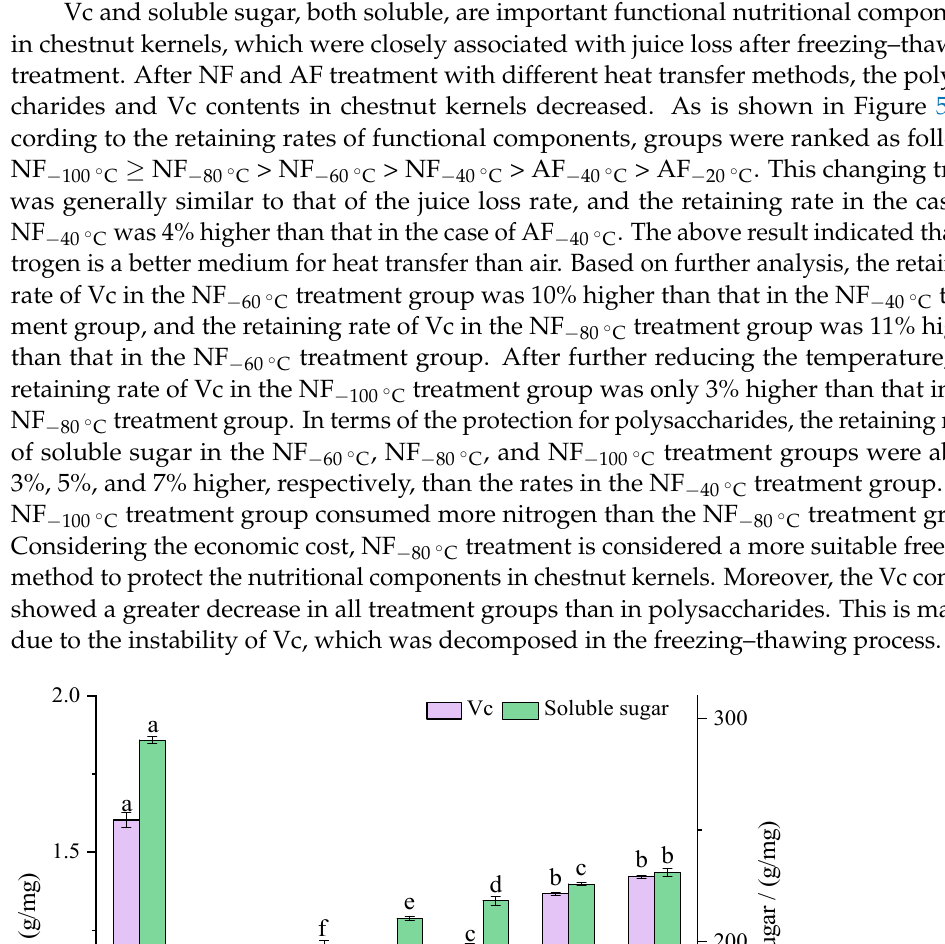
3.6. Hardness and Microstructure Changes The change trends of hardness (Figure 3a) of chestnut kernels in di ff erent treatment groups were similar to those of juice loss rate. However, the degree of hardness change (down by 41–80%) was far larger than that of the juice loss rate (down by 0.12–0.52%). This indicated that the hardness change is mainly determined by cytoskeleton change. The cel- lular microstructure is an important indicator to reveal the freezing e ff ect. Freezing brought about inevitable and complex cell damage to some extent, and it may break the cell walls and cytomembranes and change the cell osmotic pressure. Because the freezing method and rate have a signi fi cant impact on the cellular structures [2], it is necessary to fi nd a suitable freezing method to maintain the initial cellular structures best. The tissue structures of sections of fresh chestnut kernels were plump and the cells were closely arranged, as is shown in Figure 6. There were obvious di ff erences in cellular structures and arrangement between the quick-freezing groups and the slow-freezing groups after di ff erent treatment methods. The former can be tt er maintain the cellular structures than the la tt er. According to the analysis of the Confocal Laser Scanning images of mangoes conducted by Charoenrein and Owcharoen [29], after quick-freezing treat- ment, the cell walls remained round and were similar to those of fresh mangoes, while the slow-freezing treatment led to signi fi cant changes in cellular structures with lower uni-